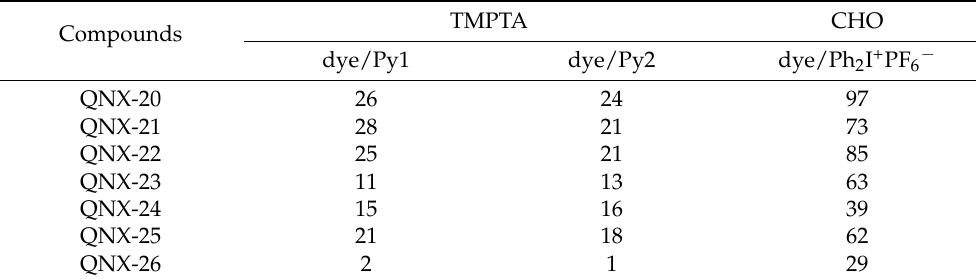
Table 8. Monomer conversions (%) obtained during the FRP of TMPTA with the two-component dye/Py1 and dye/Py2 combinations and during the CP of CHO using the two-component dye/Ph 2 I + PF 6 −